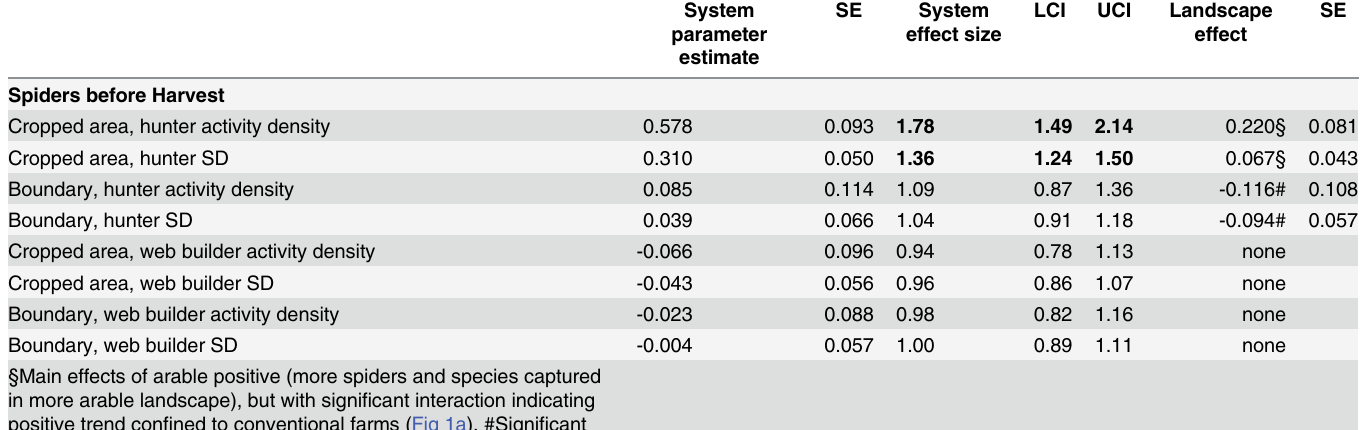
Table 3. Model averaged parameter estimates (back transformed) for farming system and landscape effects (extent of arable land in landscape). The responses were square root transformed mean species counts per trap (Species Density, SD), and log mean numbers per trap. Effect size = organic/con- ventional ratio (LCI = Lower Confidence Interval, UCI = Upper Confidence Interval). Confidence intervals not encompassing zero are